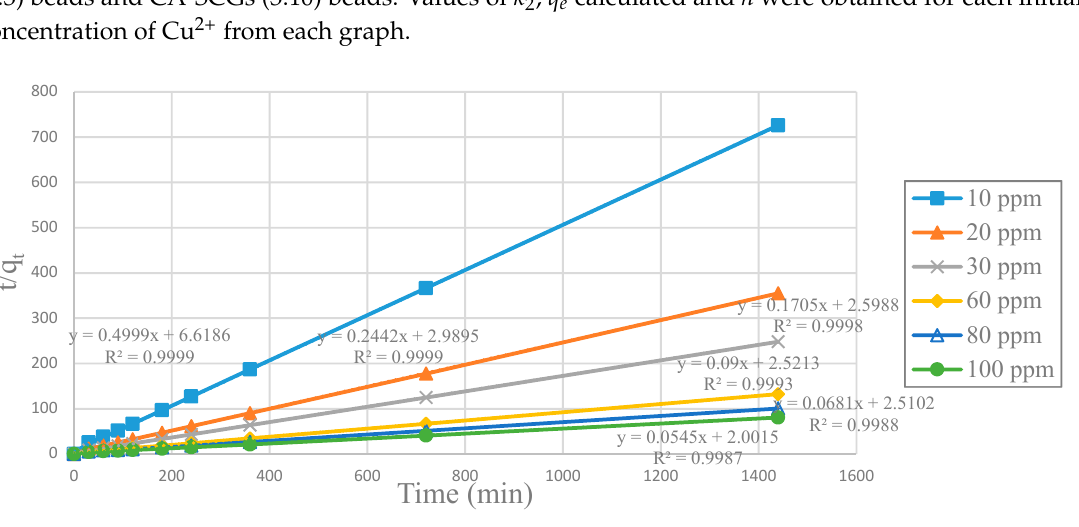
Figure 9. Plot of pseudo-second-order linear equations for CA-SCGs (3:3) beads for each initial concentration of Cu 2+ .